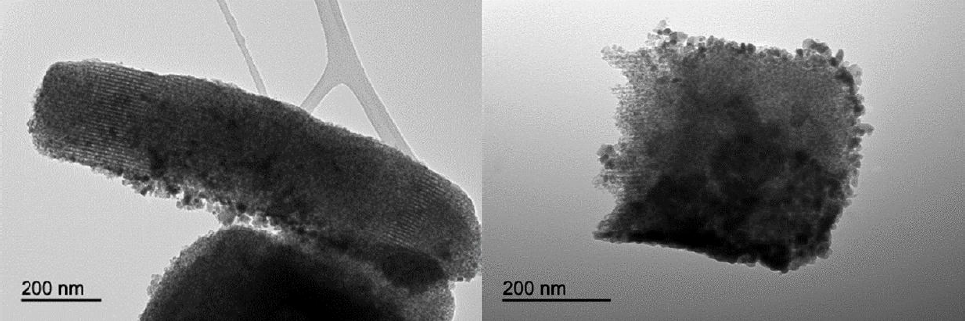
Figure 7. Transmission electron microscopy (TEM) images of 5% TiO 2 -MAGSNC photocatalysts. Table 2. Ti and Fe content on TiO 2 -MAGSNC photocatalysts (obtained from energy-dispersive X-ray spectroscopy (EDX) analysis).